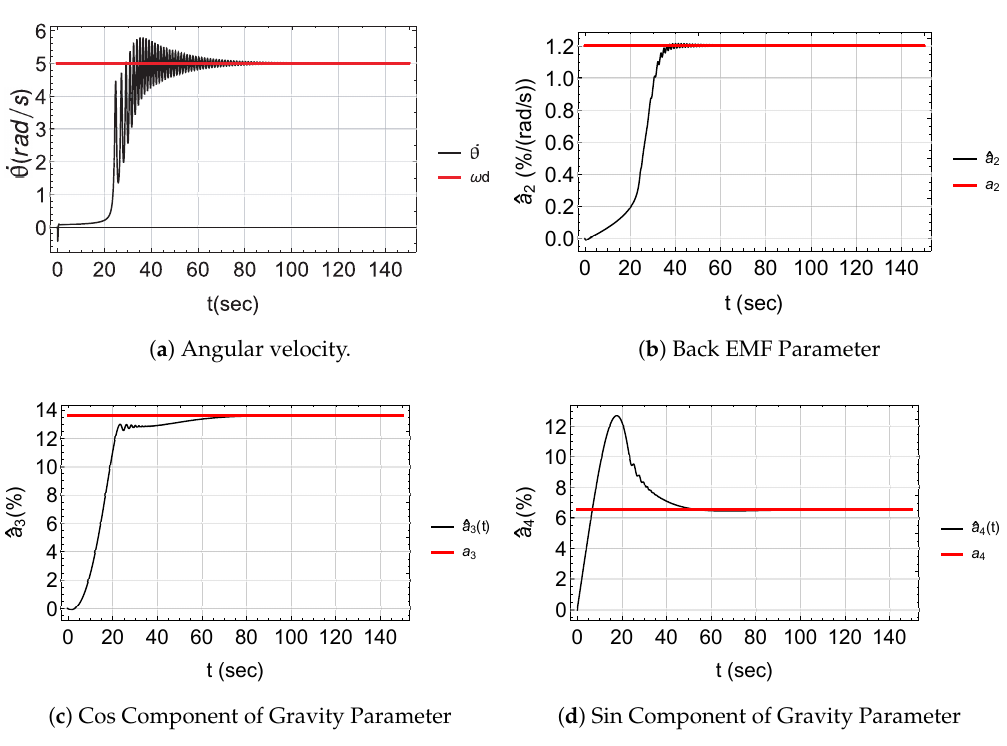
Figure 6. Simulation Results for Convergence of